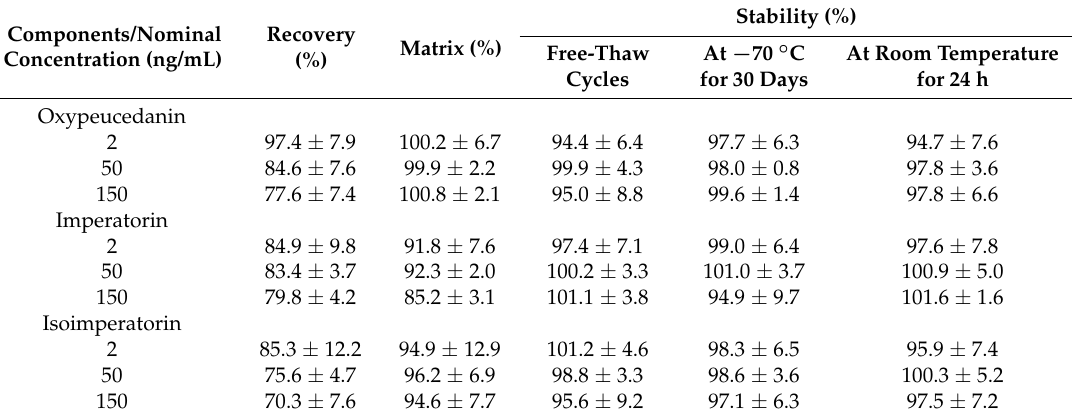
Table 3. Extract recovery, matrix effects, and stability of oxypeucedanin, imperatorin, and isoimperatorin in rat